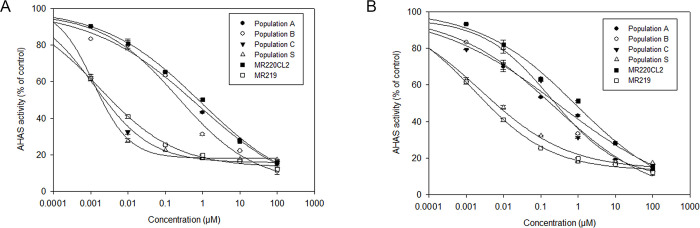
A.
In vitro inhibition of AHAS activity by imazapic in weedy rice populations and control rice varieties. Data are expressed as means and standard errors of the mean, calculated from three extractions and four assays for each plant. B.
In vitro inhibition of AHAS activity by imazapyr in weedy rice populations and control rice varieties. Data are expressed as means and standard errors of the mean, calculated from three extractions and four assays for each plant.